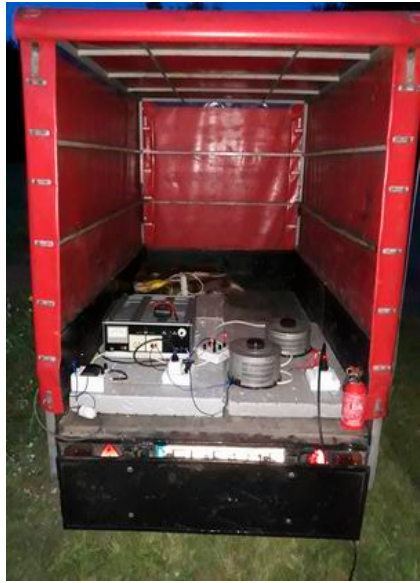
Figure 6. The trailer with the power system.